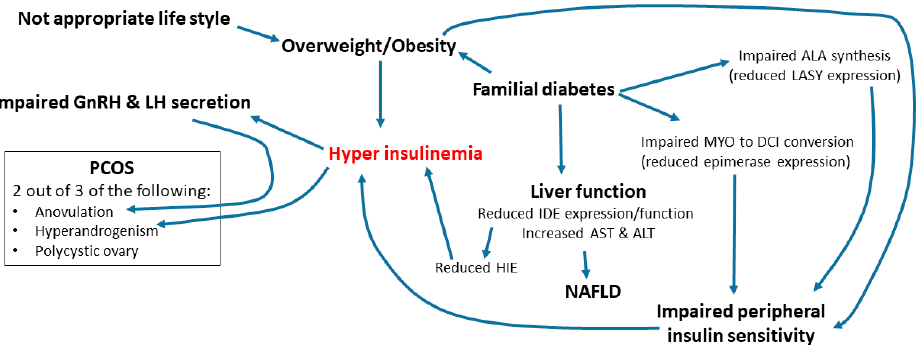
Figure 1. Schematic representation on the role of metabolism impairments in triggering the endocrine impairments of PCOS. An inappropriate lifestyle and/or the coupling with familial diabetes are the main triggers of the insulin resistance that activates the compensatory hyperinsulinemia. Various reduced enzymatic expressions occur in case of familial diabetes and are responsible of the insulin resistance due to peripheral reduced insulin sensitivity.